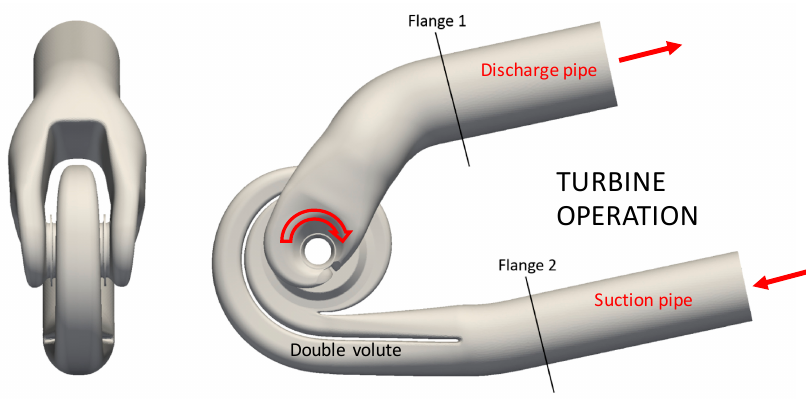
Figure 15. Numerical domain with the turbine operating conditions.